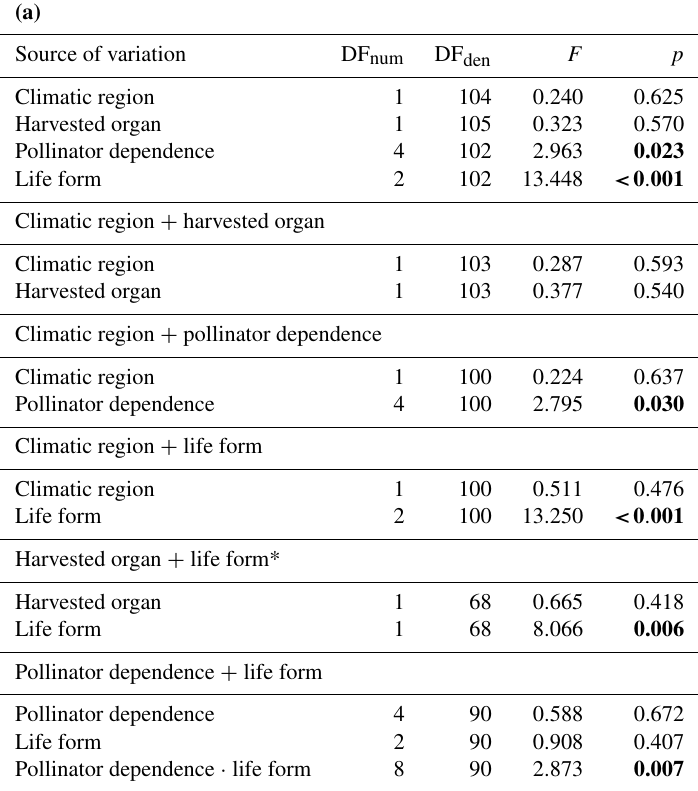
Table A4. Analysis of variance of PGLS fitted models for (a) mean yield growth ( (cid:49) yield) and (b) interannual yield variation (SD( (cid:49) yield)), with climatic region, type of harvested organ, pollinator dependence, and crop life form as sources of variation. Marginal sums of squares (type III) were estimated for models with more than one source of variation by applying the R function “anova” (with the op- tion “type = marginal”) on the PGLS fitted objects. Interaction terms were only kept in the models when their inclusion increased model fit in terms of AIC ( (cid:49) AIC ≥ 2); all interactions between predictors not informed were statistically non-significant ( p > 0 . 05). Significant tests ( p < 0 . 05) are indicated in bold